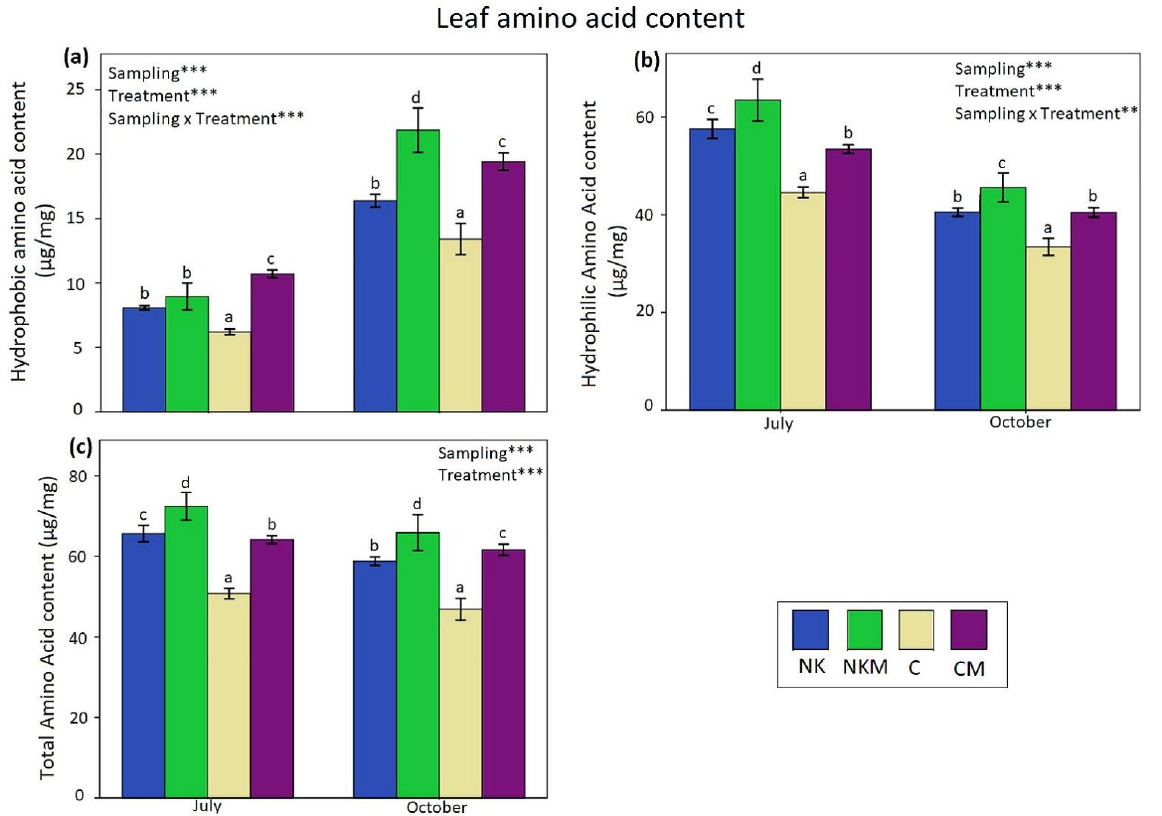
Figure 6. ( a – c ) Mean values (±SE) of leaf hydrophobic ( a ), hydrophilic ( b ) and total ( c ) amino acid content, as recorded in July, October and February samplings of all treatment groups (NK: KNO 3 fertilizer; NKM: KNO 3 in combination with PGPR; C (Control): NH 4 NO 3 fertilizer and CM: NH 4 NO 3 fertilizer in combination with PGPR). “Sampling”, “Treatment” and “Sampling × Treatment” on the top of the graphs indicate a significant effect of the sampling period, the treatment or their interactive effect, respectively, as revealed by ANOVA (** p < 0.01, *** p < 0.001). Different superscript letters denote significant differences between treatments (a: corresponds to the lowest value).